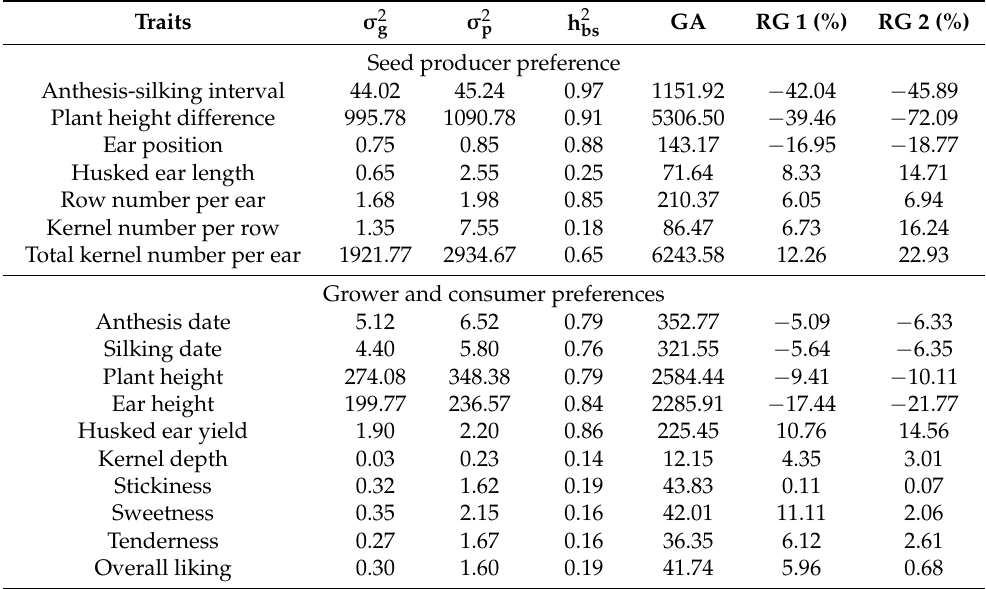
Table 4. Estimates of genetic parameters and genetic gains of seed producer, grower, and consumer preferences at 10% simultaneous